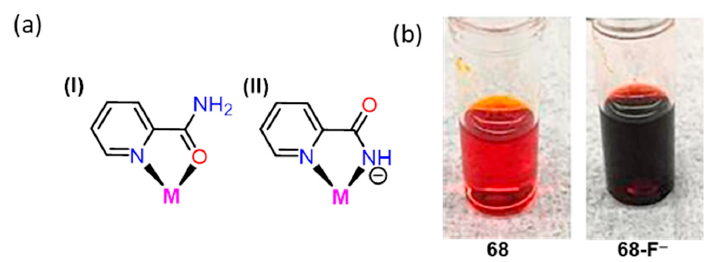
Figure 10. ( a )Two coordination modes of 2-picolinamide: (I) H 2 pia-k 2 N,O (II) Hpia-k 2 N,N’; ( b ) The naked eye color of the solution of only 68 (left), and after adding TBAF (right). [Adapted from reference [91]; © 2023 Elsevier B.V. All rights reserved].